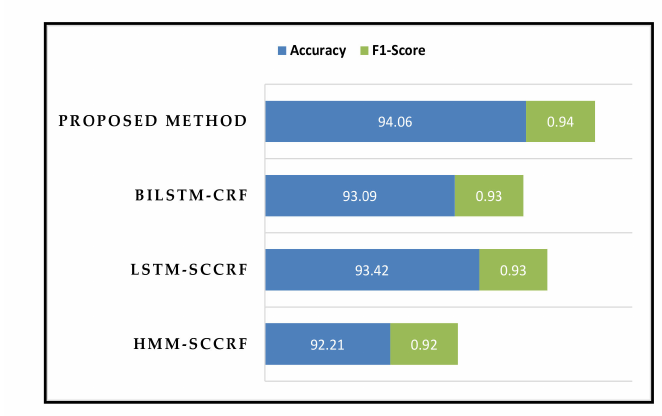
Figure 17. Overall accuracy and F-score of the proposed